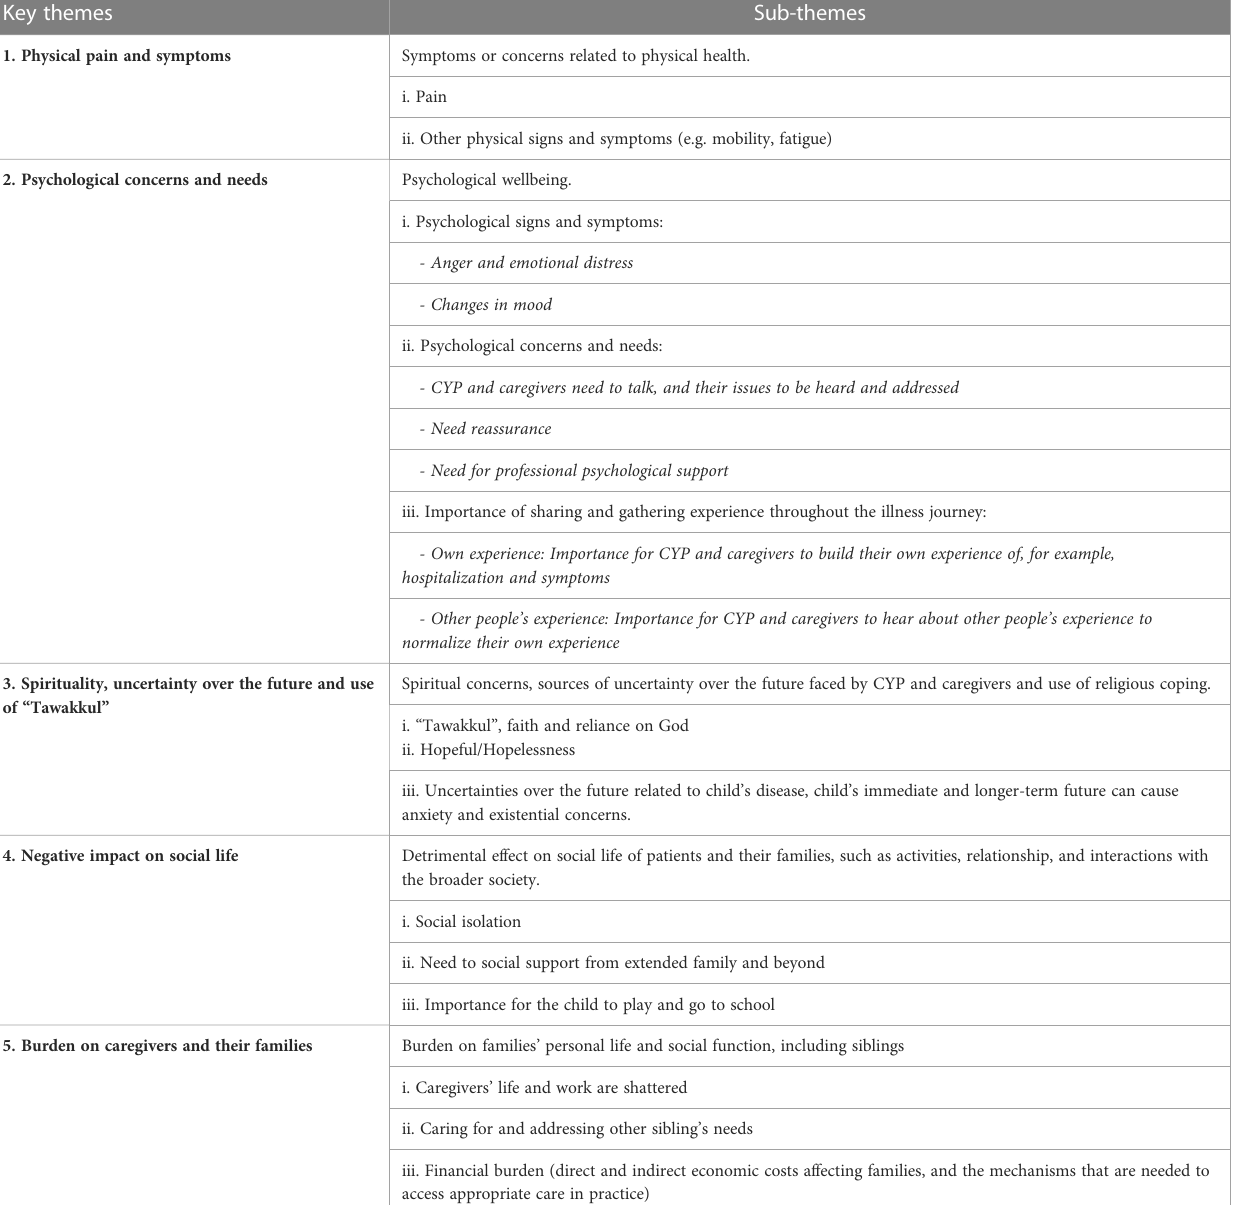
TABLE 3 Key concerns and priorities for children and young people with advanced cancer, their families and palliative care providers in Jordan and Turkey. Key